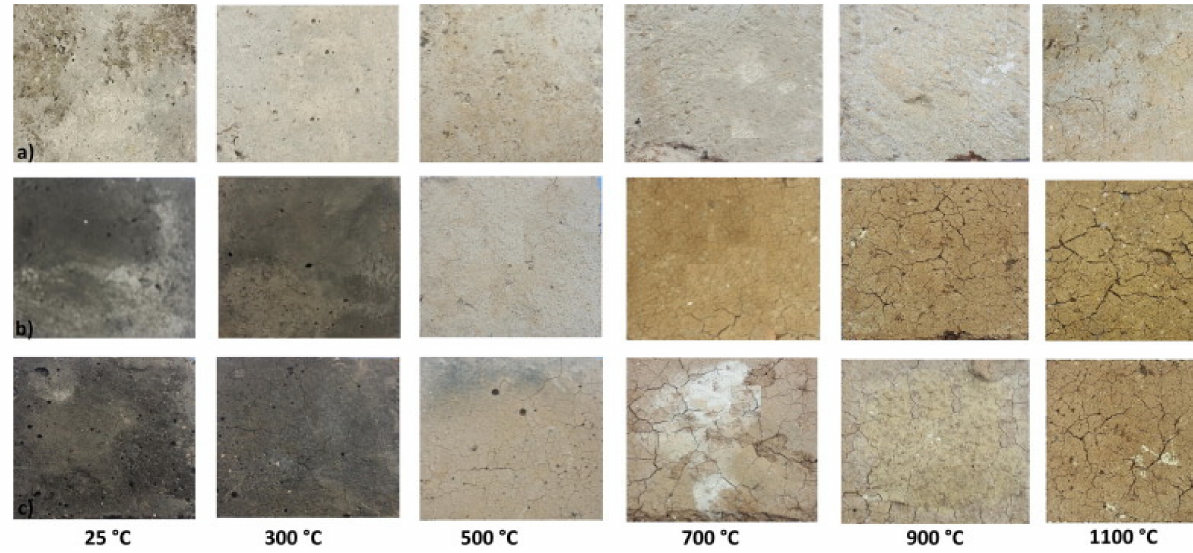
Figure 18. Exposure to elevated temperature of Portland ( a ), FA-GBFS ( b ), and FA ( c ) concretes: texture and cracks distribution. Reprinted with permission from Ref. [99]. Copyright 2017 Elsevier.